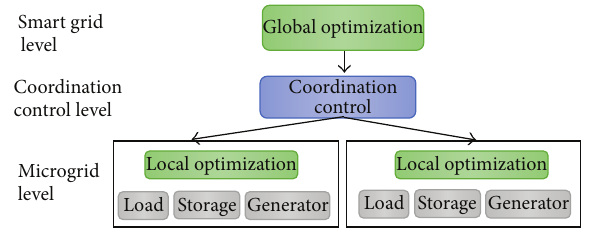
Figure 1: Conventional smart grid